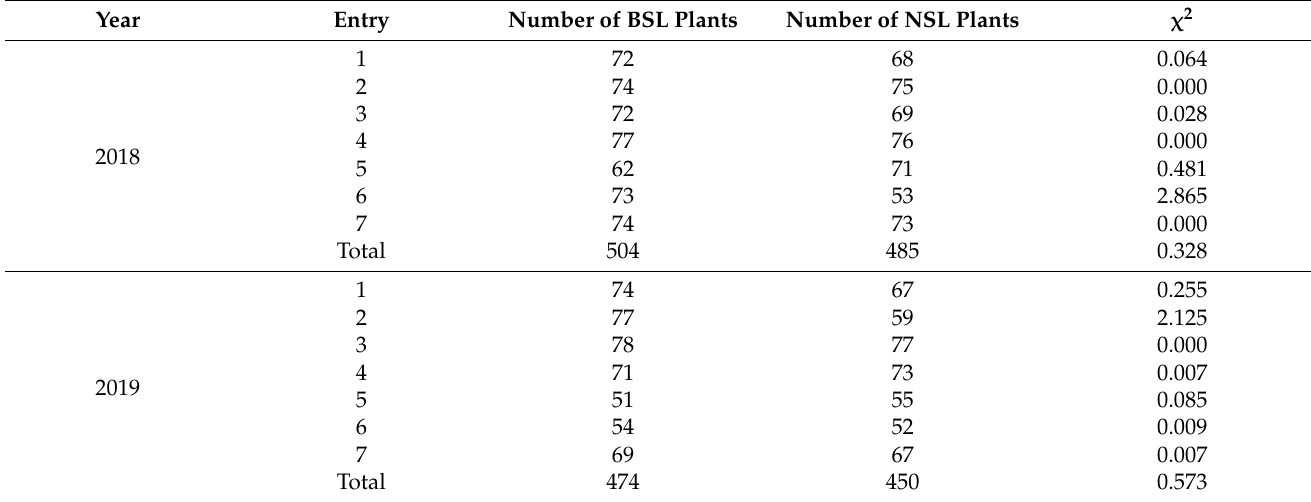
Table 1. Segregation ratio of BSL and NSL plants in the inbred progenies from BSL plants in the years of 2018 and